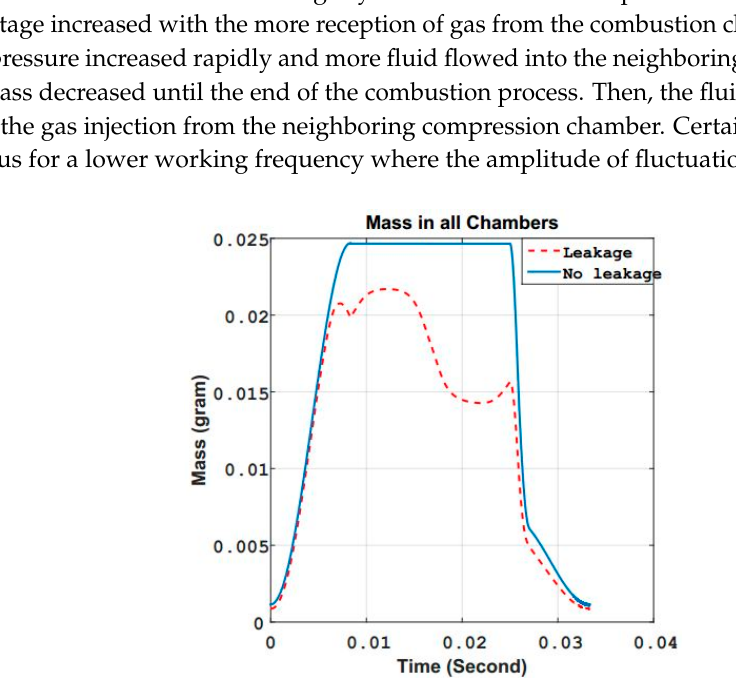
Figure 12. Mass of working fluid vs. time over one cycle (100 Hz). The temperature of the working fluid changes in accordance with pressure and the curves are expressed in Figures 13 and 14. Whether the leakage effect is considered or not, the fluid temperature changes in a similar trend, for a certain working frequency. However, influenced by this irreversible loss, the fluid remains heated for the entire cycle. The reason for the pressure changing process is given as follows.